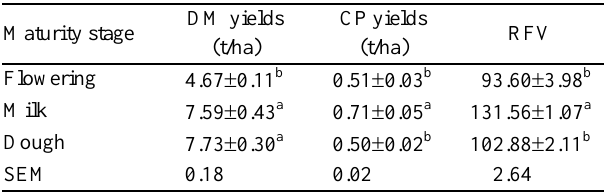
Average means  standard deviations.